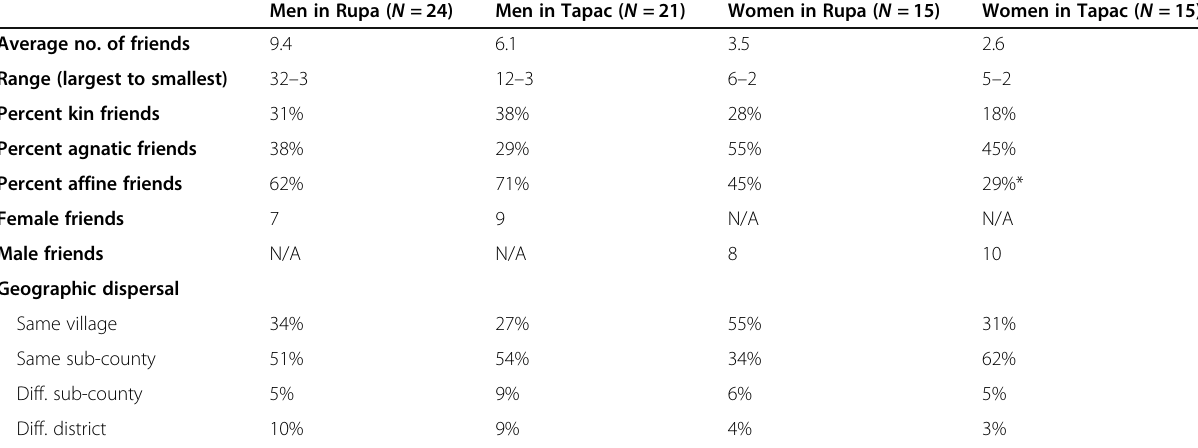
Table 1 Characteristics of men and women ’ s friendship networks in Rupa and